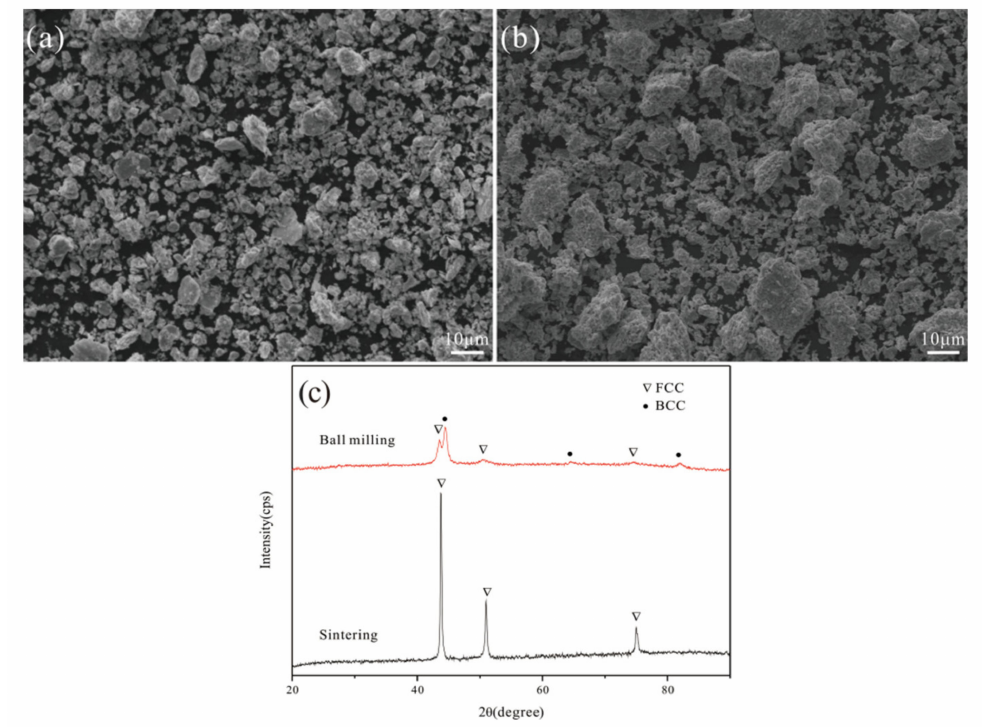
Figure 2. Morphologies and phase compositions of Al 0.25 FeNiCoCr powders after ball milling 50 h and vacuum sintering: ( a ) ball milling, ( b ) vacuum sintering, and ( c ) phase